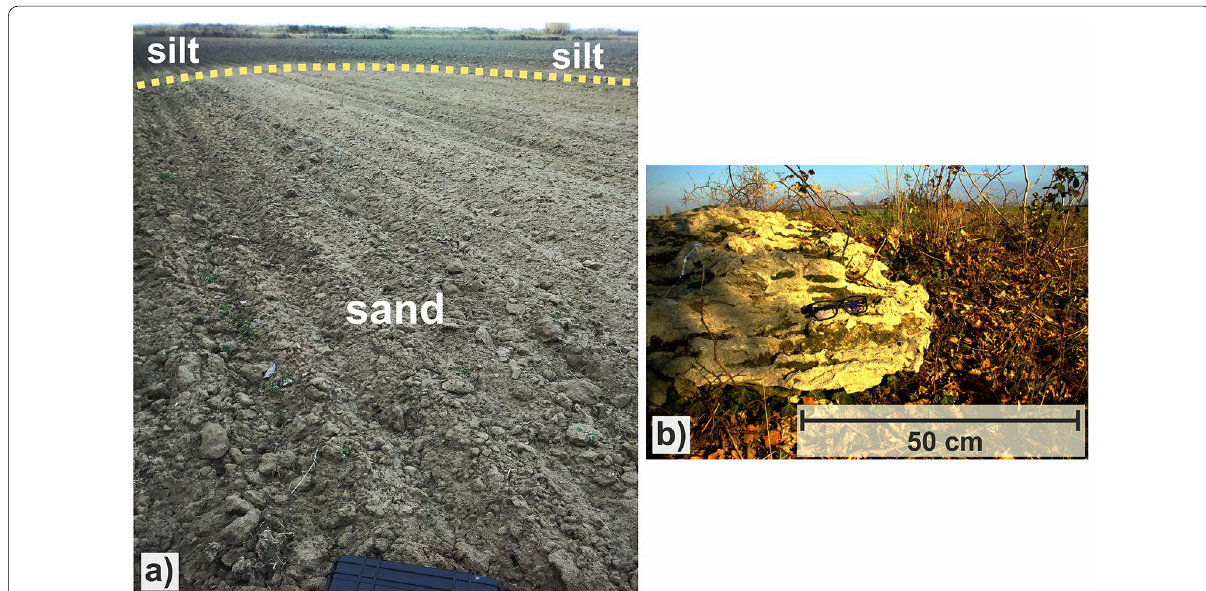
Fig. 9 Some surface evidences: a Beligna#1 area from the Point of View (POV) indicated in Fig. 8a: the presence of sandy sediments (light colours in the foreground) in an area otherwise dominated by silty soils (dark colours in the background) is apparent. The dotted line highlights the abrupt passage from these two different kinds of sediments and is particularly evident in winter time when no vegetation/crop masks the superficial sediments; b large boulders of cemented sand found nearby the P2 point (see Fig. 2b)